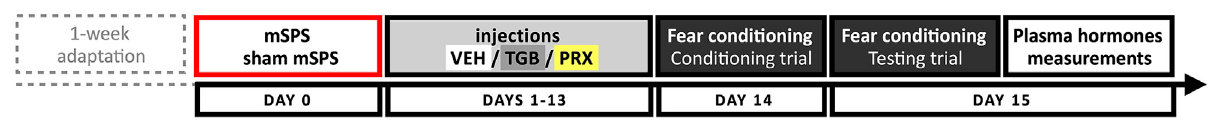
FIGURE1| Experimentalschedule.MaleandfemalemicewereexposedtomSPS(N (cid:2) 24+24)orshammSPS(N (cid:2) 24+24).Twenty-fourhoursfollowingtrauma, 13-days long treatment with tiagabine (TGB, 10 mg/kg, i.p.) pramipexole (PRX, 1 mg/kg, s.c.) or saline began. On days 14 – 15, conditioned fear was examined, and 1 h later,theanimalsweredecapitated,andbloodsampleswerecollectedforfurtherevaluationofplasmacorticosterone,testosterone,and17 β -estradiol(foreachhormone and sex, N (cid:2) 8). Abbreviations: mSPS – mouse single prolonged stress, PRX – pramipexole, TGB –